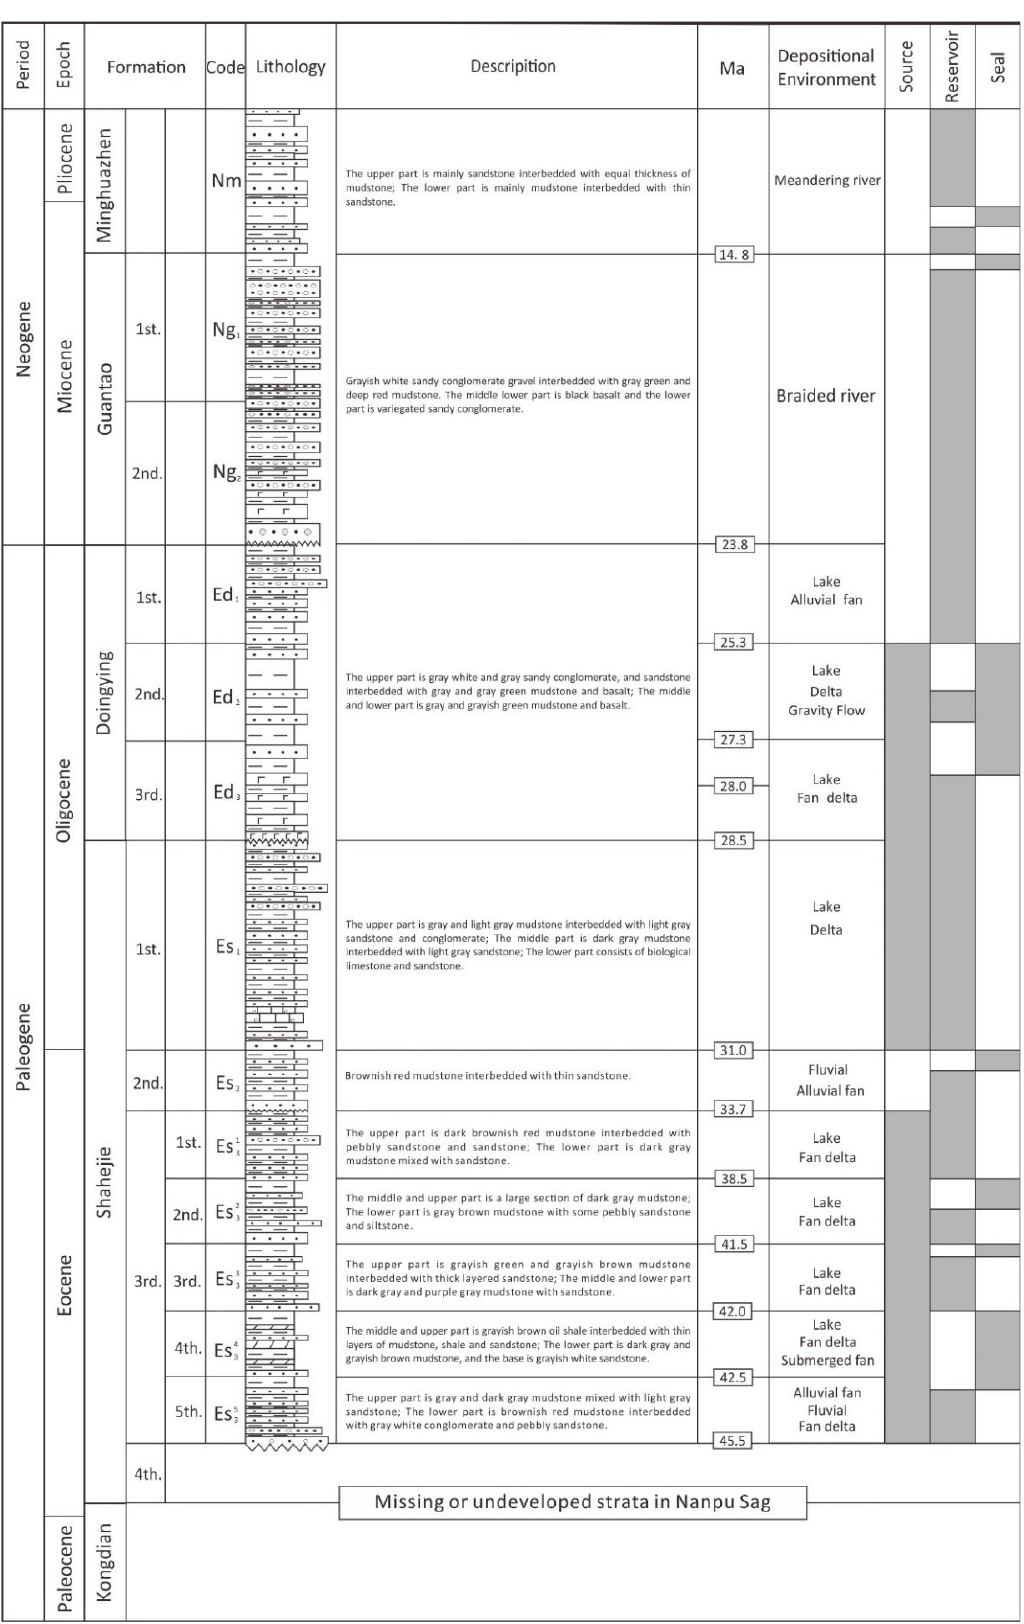
Figure 2. General Paleogene-Neogene stratigraphy of Nanpu Sag with information about depositional environment and hydrocarbon system elements [30,39].